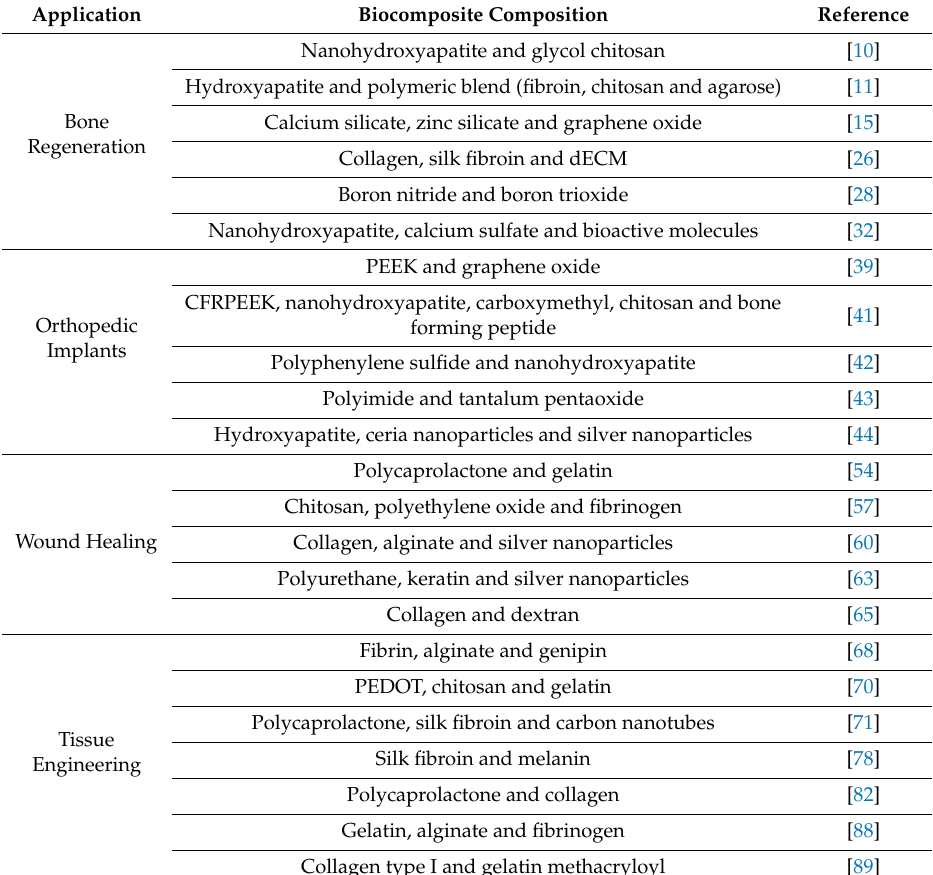
Table 1. Summary of Biomedical Applications of